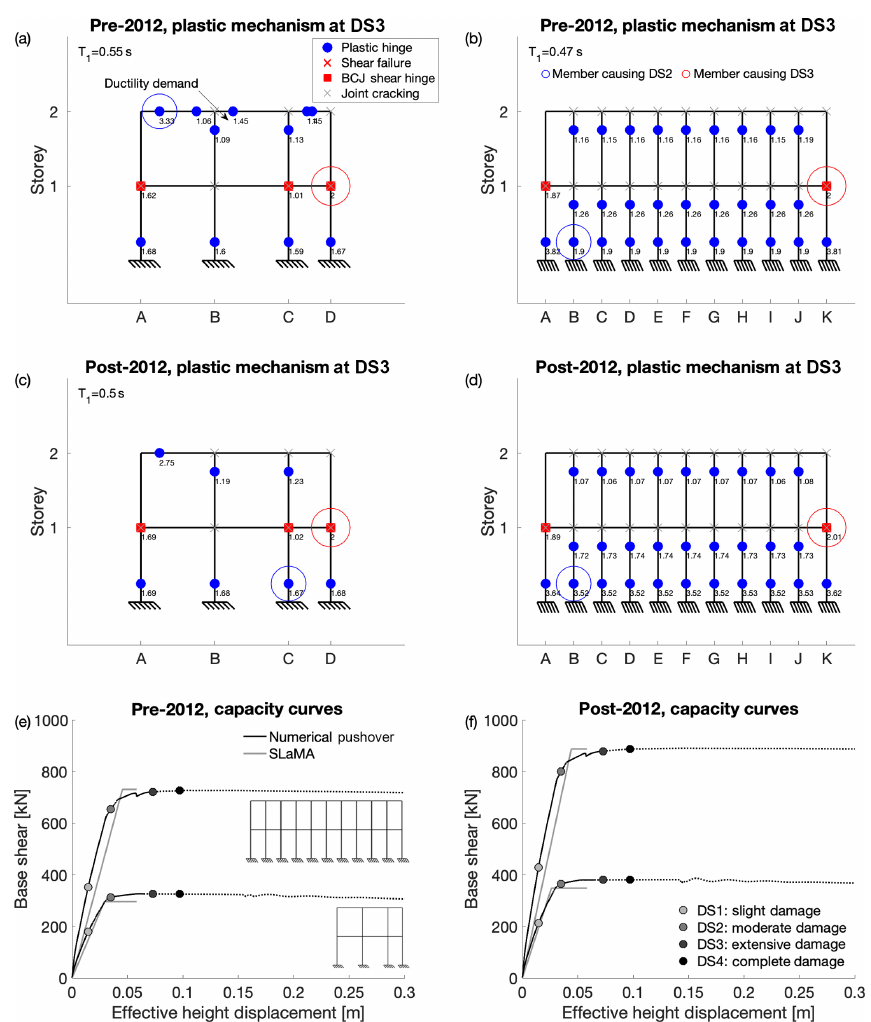
Figure 11. Non-linear static analyses results for the archetype building. (a–d) Plastic mechanisms at DS3; (e–f) capacity